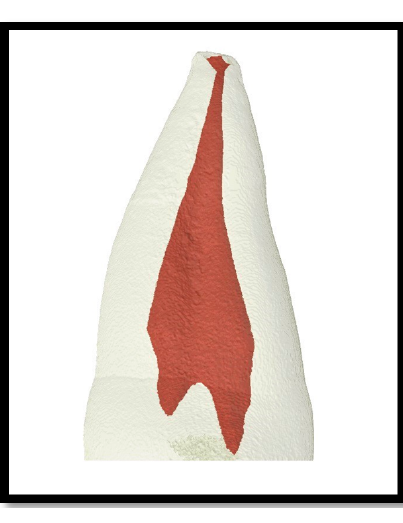
Figure 1. Micro-CT image showing Vertucci’s type I (1-1) canal configuration.